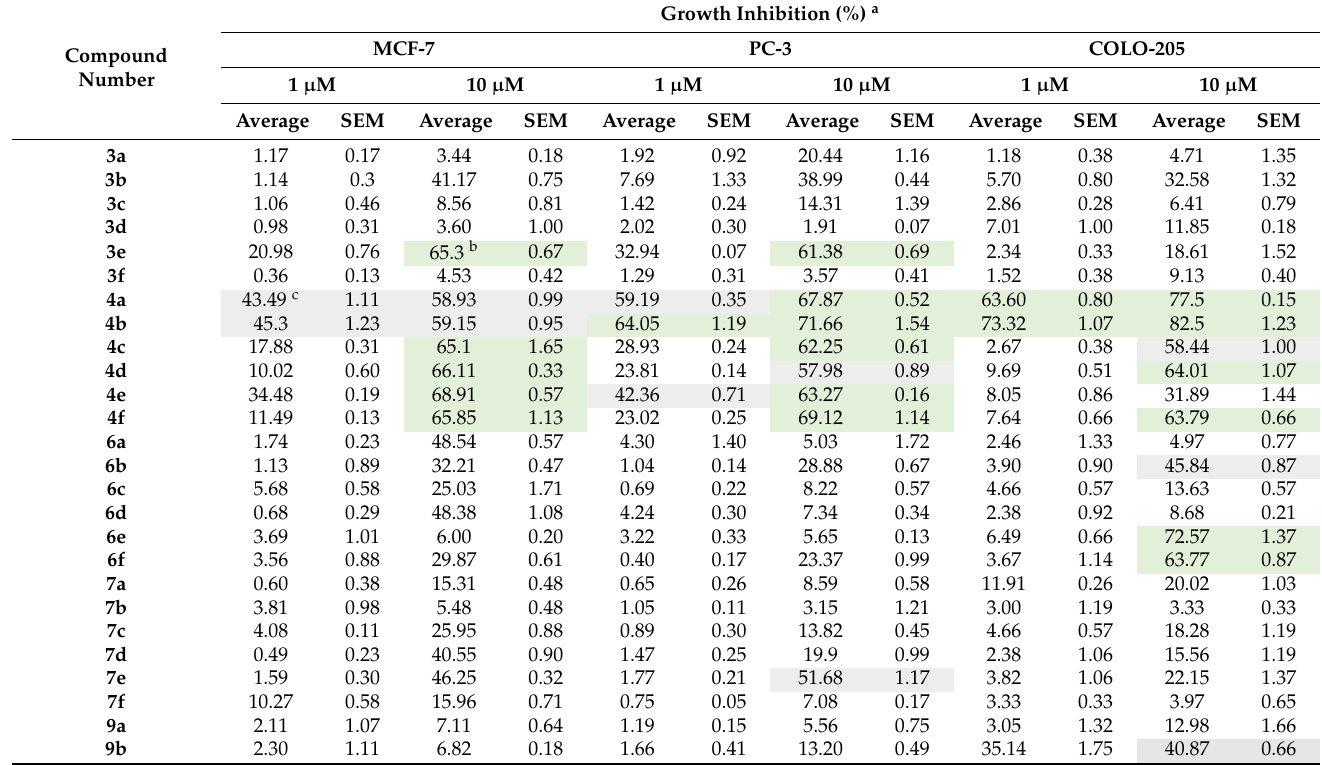
Table 1. Growth inhibition (%) of MCF-7, PC-3 and COLO-205 cancer cell lines treated with compounds 3a–f, 4a–f, 6a–f, 7a–f and 9a–b at 1 and 10 µ M doses using the SRB